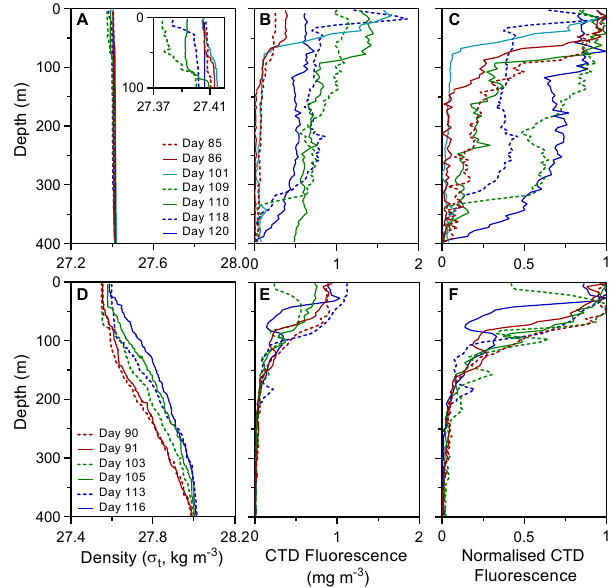
Figure 2. Upper water column profiles for the ICB (a, b, c) and the NWB (d, e, f) , of density (a, d) , CTD fluorescence (b, e) , and CTD fluorescence normalised to peak CTD fluorescence for each profile (c, f)